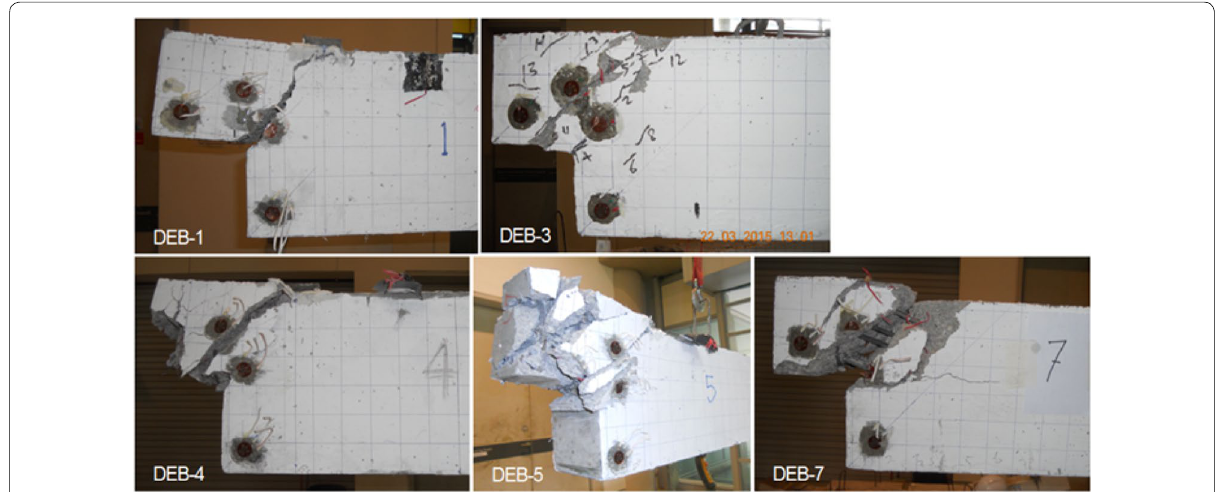
Fig. 9 The beams condition after testing (For DEB-1,-3,-4,-5 and